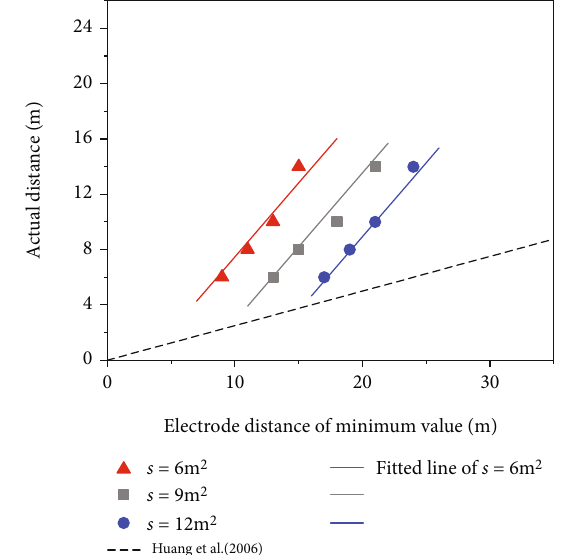
Figure 9: Fitted curves for tunnel size and the electrode distance of minimum